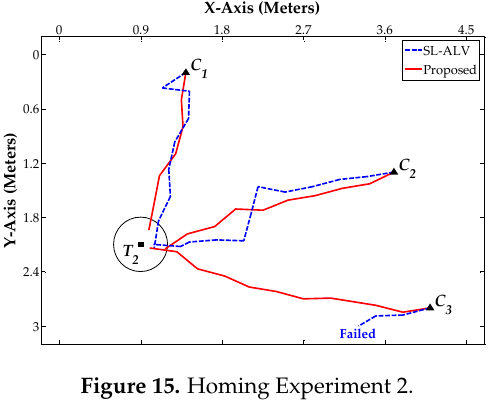
Figure 15. Homing Experiment 2. Sensors 2018 , 18 , x FOR PEER REVIEW Table 5. Associated results of homing experiment 2.